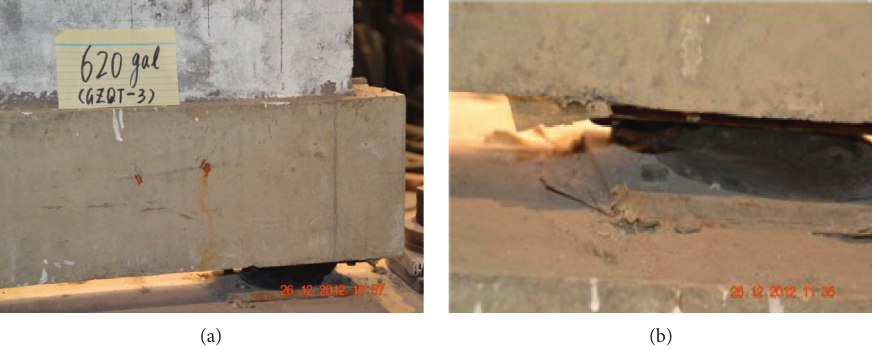
Figure 7: MLQT-3: (a) LRB limit of displacement state; (b) LRB broken state.